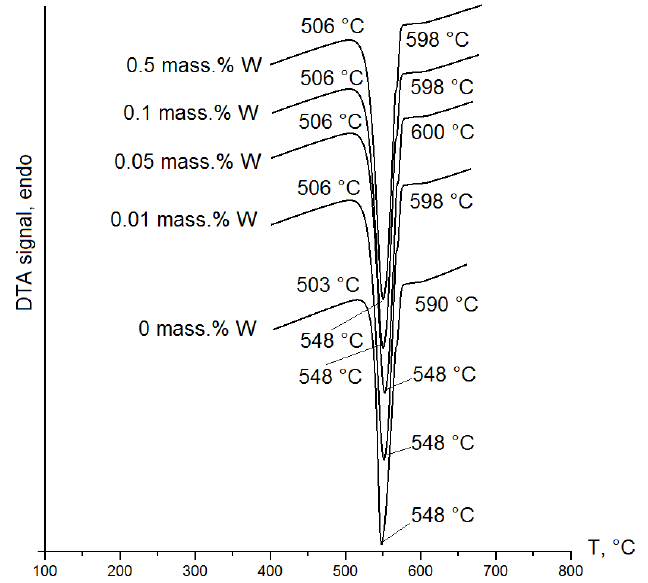
Figure 7. DSC-curve of Al-12%Si alloys with 0.01–0.5 mass % of W.